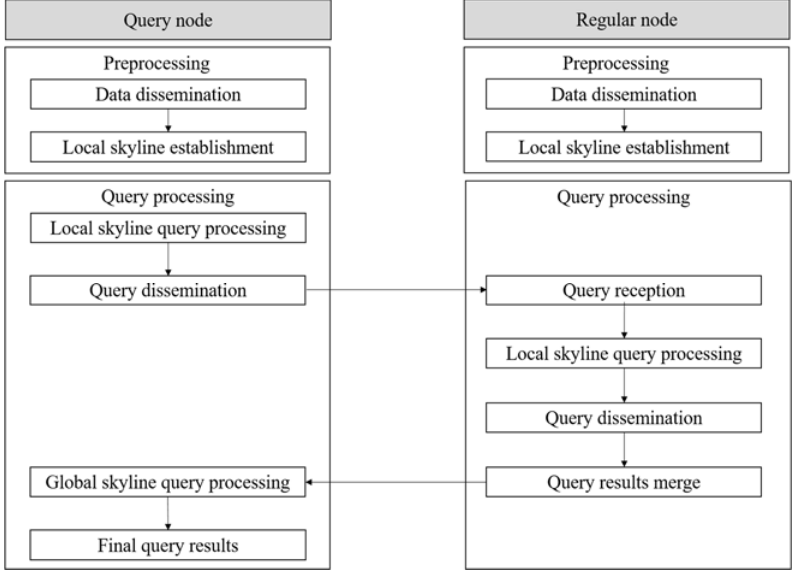
Figure 2. Overall query ‐ processing procedure.